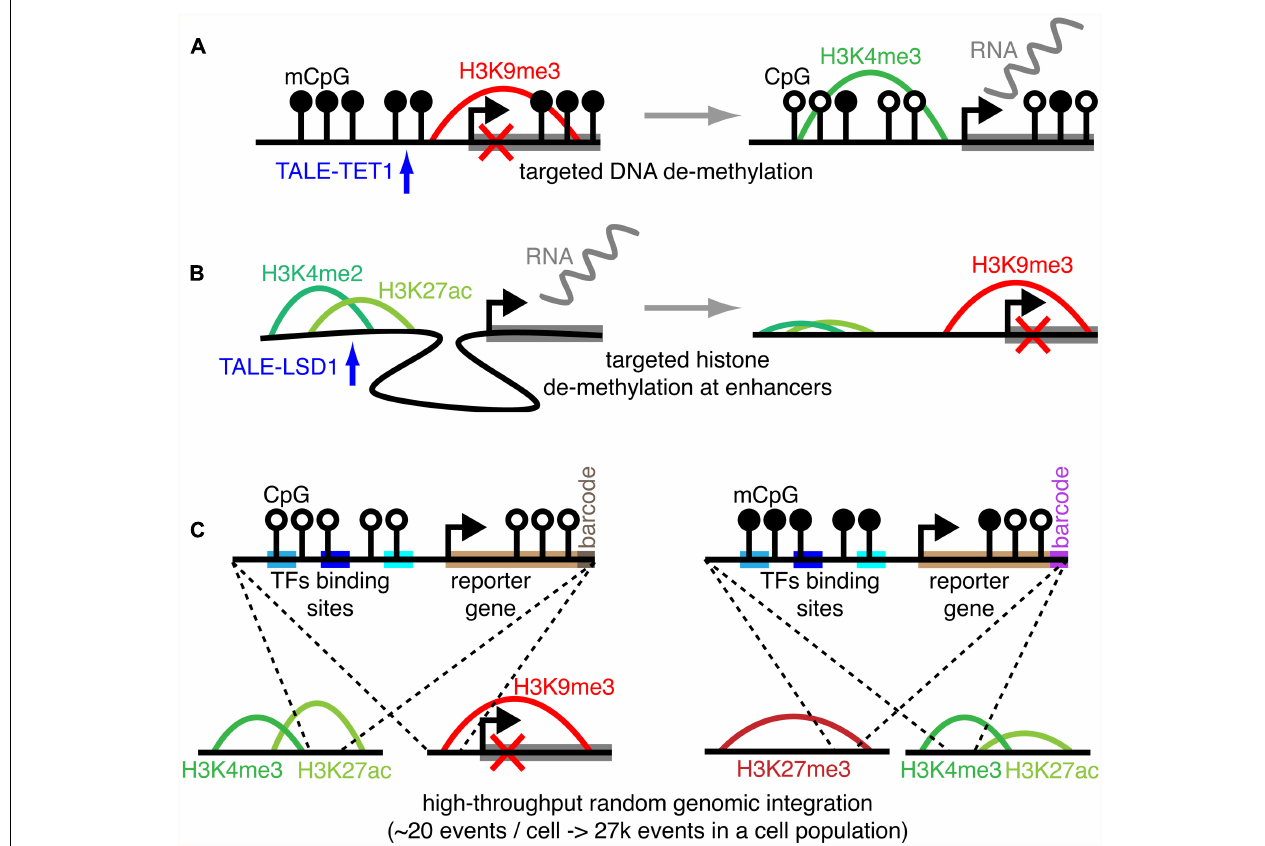
and the transcriptional repression of the target gene (B) . Simplified representation of the thousands of reporters integrated in parallel (TRIP) method that can be used to probe the epigenome with reporter genes set under control of specific regulatory and epigenetic input, here depicted as transcription factor (TFs) binding sites and DNA methylation (C)